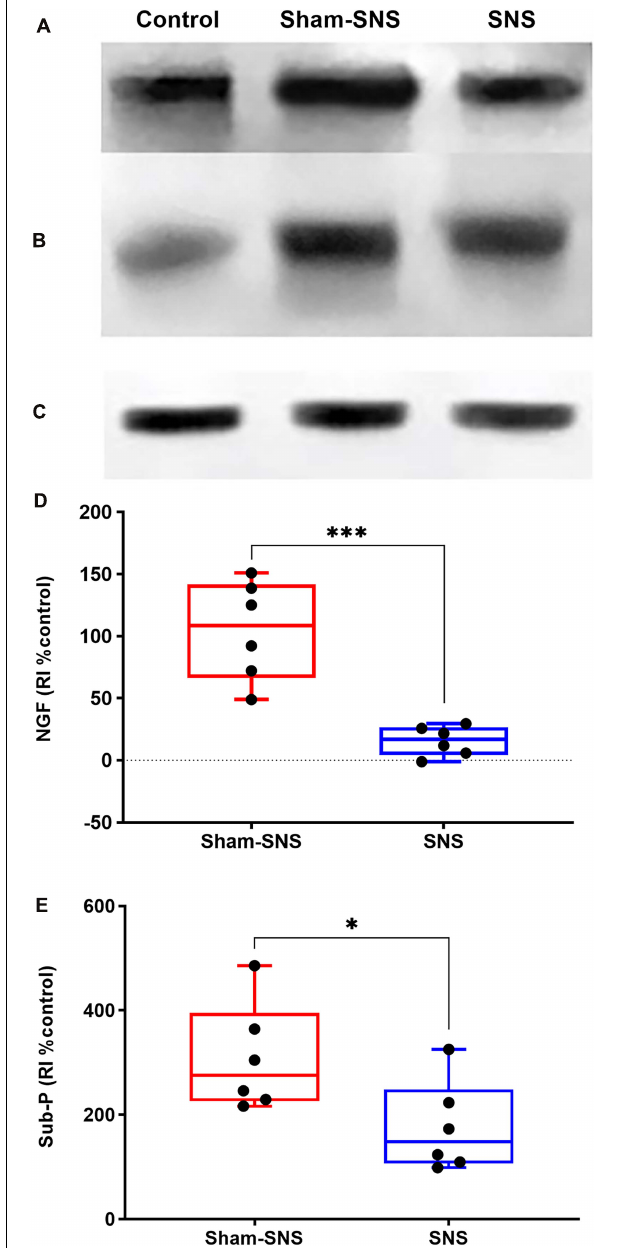
FIGURE 8 | Effects of chronic SNS and sham-SNS on protein expression of NGF (A,D) , Sub-P (B,E) , and GAPDH (C) in middle third of colon of visceral hypersensitive rats in comparison with the control (normal rats). Panel (A) shows NGF immunoblot (140 kDa) and panel (D) represents the percent change of protein expression of NGF in colon tissue compared to control group. SNS markedly downregulated NGF protein expression in colon tissue after 3 weeks treatment. Panel (B) shows Sub-P immunoblot (50 kDa) and panel (E) displays the percent change of protein expression of Sub-P in colon tissue compared to control group. Sub-P that was upregulated in sham-SNS group was downregulated after a 3-week SNS. Values were represented as the means ± SE ( n = 6) as percentage of relative intensity normalized to internal control (GAPDH, 36 kDa). NGF, nerve growth factor; Sub-P, substance-P; SNS, sacral nerve stimulation, RI, relative intensity (* p < 0.05, *** p < 0.001; Student t